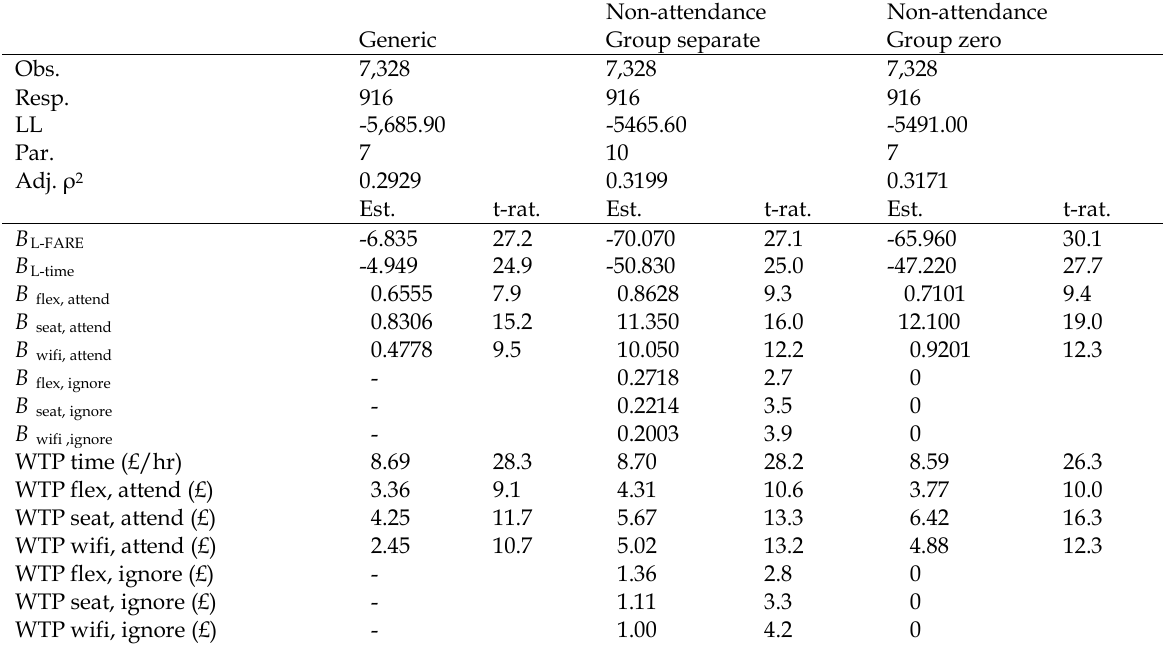
Estimation results for stage 1